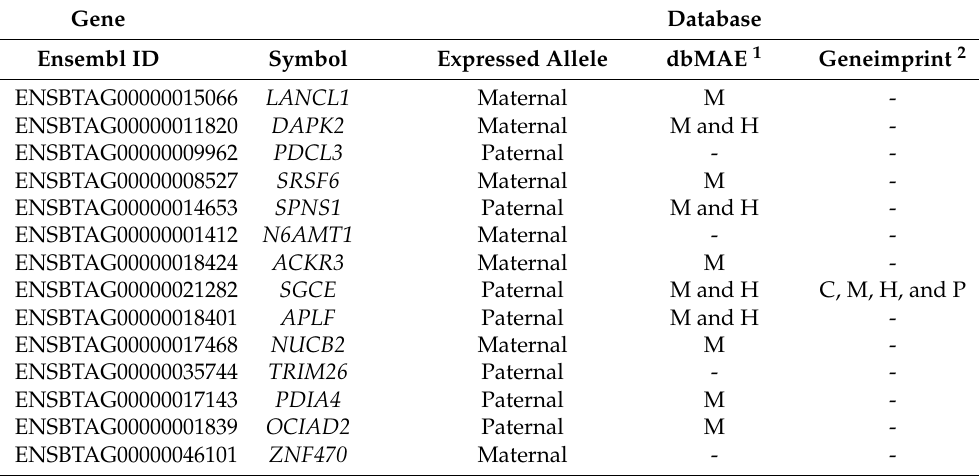
Table 1. Genes with monoallelic expressions in muscle, fat, and brain tissues of